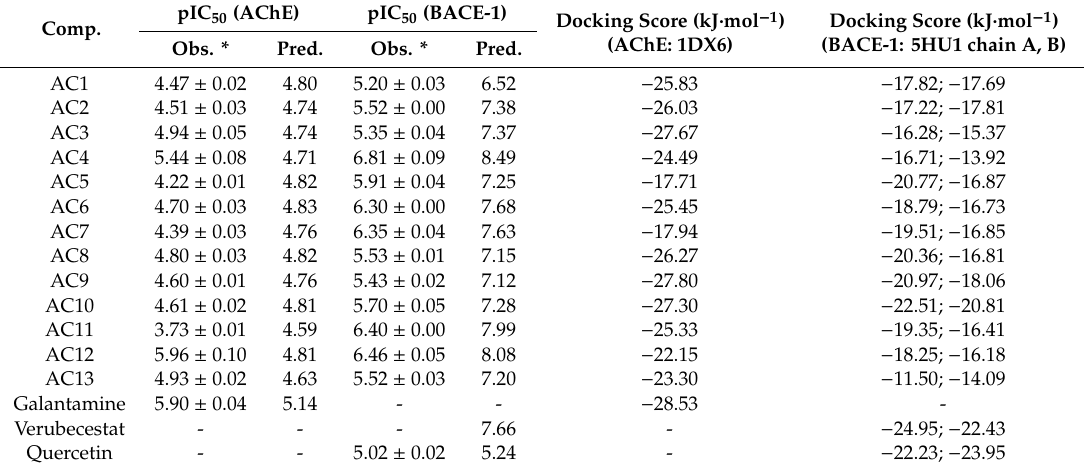
Table2. Resultsofmoleculardockingstudyofthesynthesized N -substituted-4-phenothiazine-chalcones on AChE (1DX6) and BACE-1